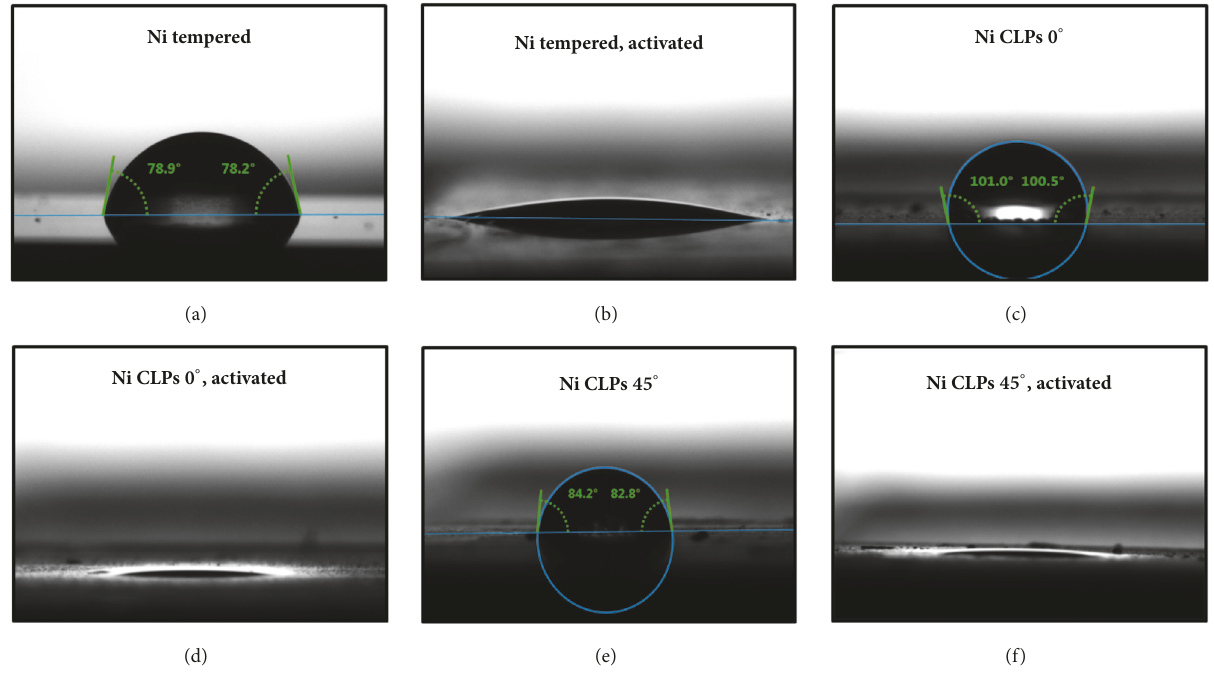
Figure 5: Contact angle measurements of the tempered Ni plate as prepared (a) and activated (b), Ni CLPs 0 ∘ as prepared (c) and activated (d), and Ni CLPs 45 ∘ as prepared (e) and activated (f). The measurements were carried out with a deionized water droplet (V = 1 𝜇 L). The activated electrodes show superhydrophilic behavior; therefore determination of the contact angle was not